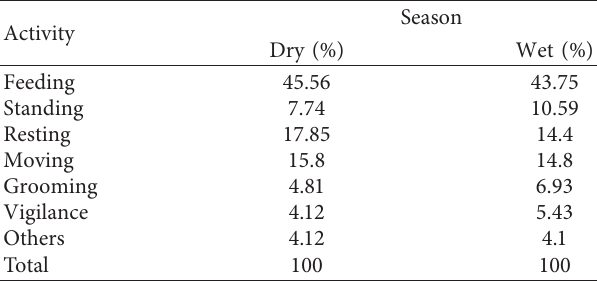
Table 4: Activity budgets of the observed klipspringers during the wet and dry